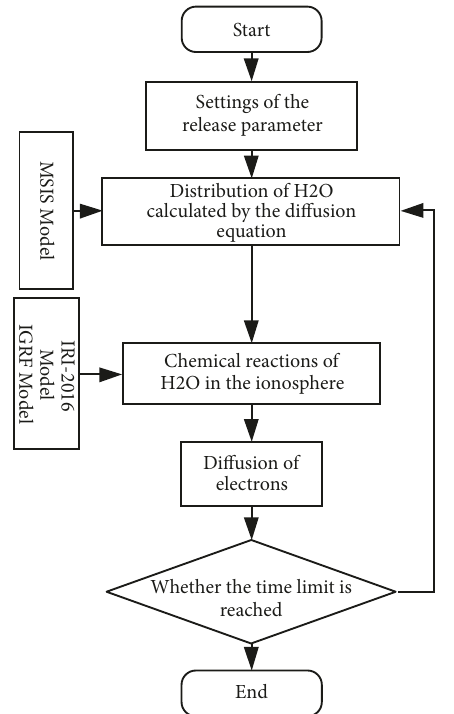
Figure 1: Flow chart of ionosphere disturbance by ballistic missile exhaust plume.